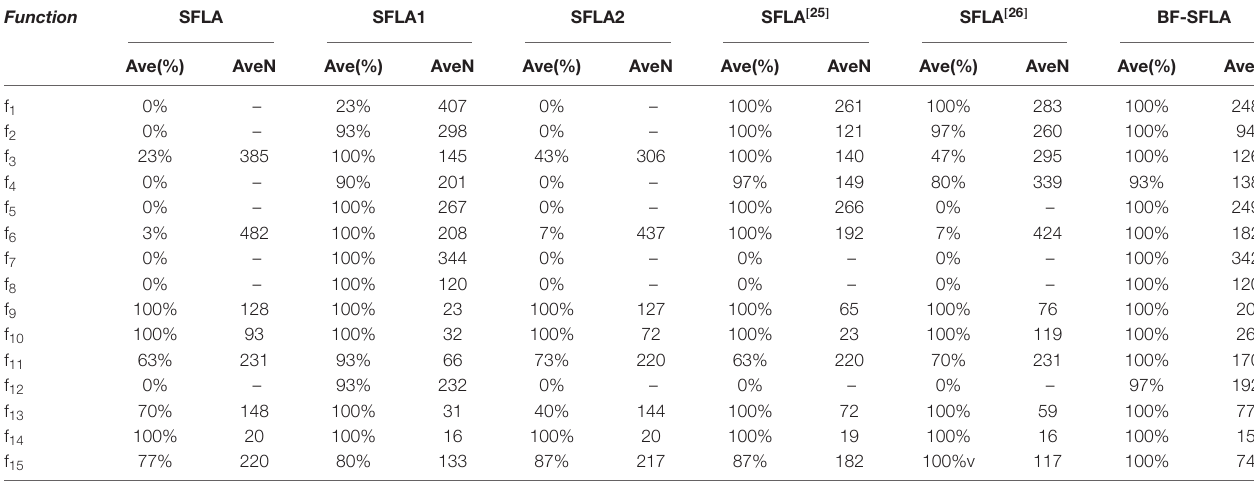
TABLE 3 | The experimental results under fixed optimization accuracy.